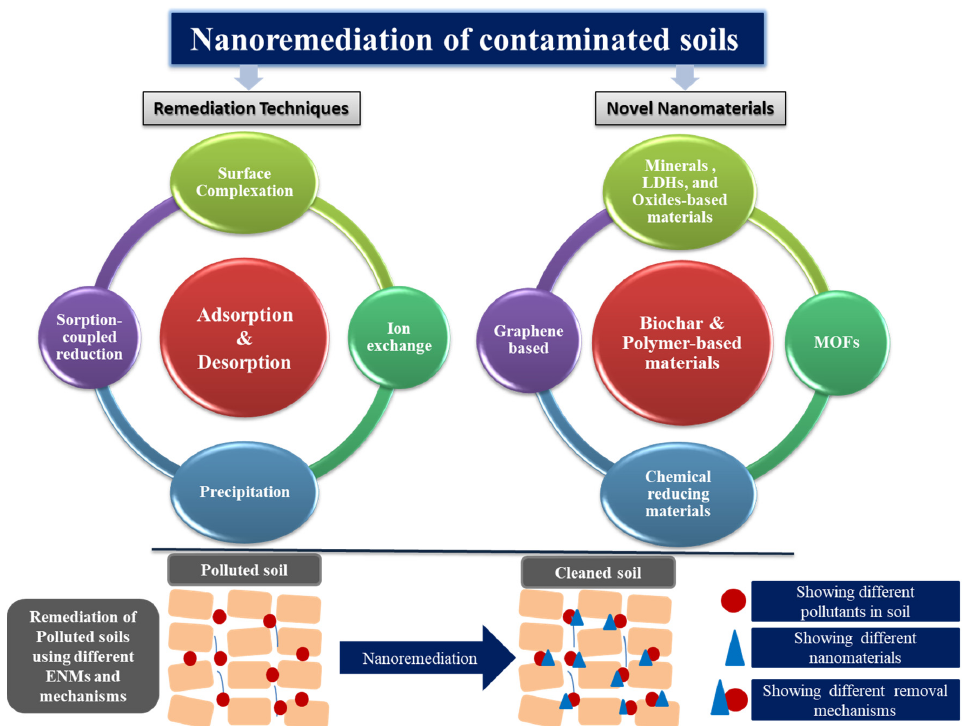
Figure 3. Schematical representation of innovative materials, remediation techniques, and potential removal mechanisms exploited for remediation of polluted soils. Table 3. Latest innovations regarding nano-enabled materials for soil remediation.